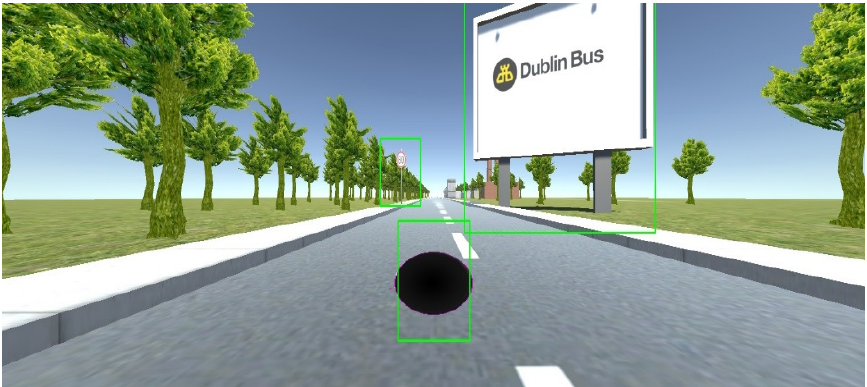
Figure 5. AOI bounding boxes